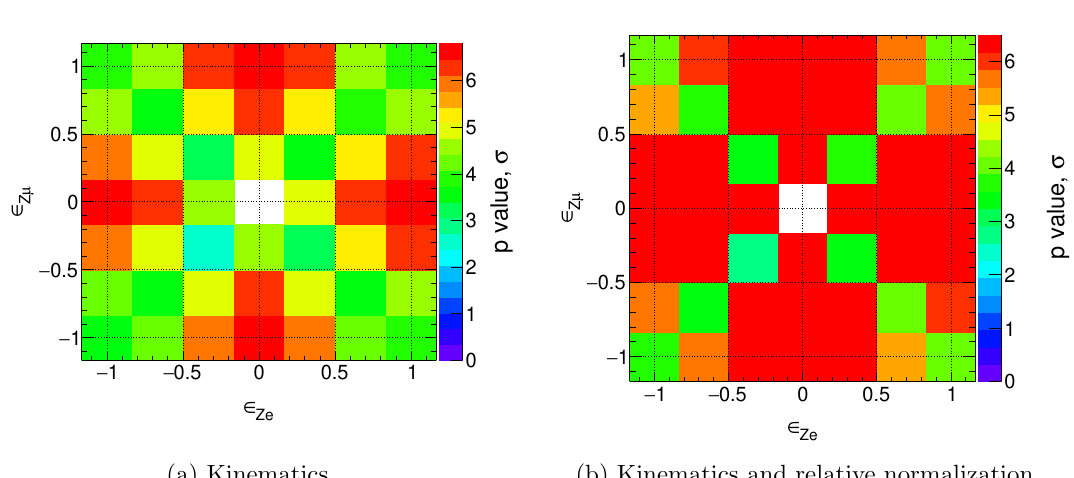
Figure 3. The left (cid:12)gure is the same as (cid:12)gure 2a, except that in this case we are considering the benchmark scenario 5, in which the anomalous PO are (cid:15) Ze = (cid:15) Ze The right (cid:12)gure is obtained also for scenario 5 but including not only kinematics but also information about the relative normalization of the various H ! 4 ‘ (cid:13)avor channels.